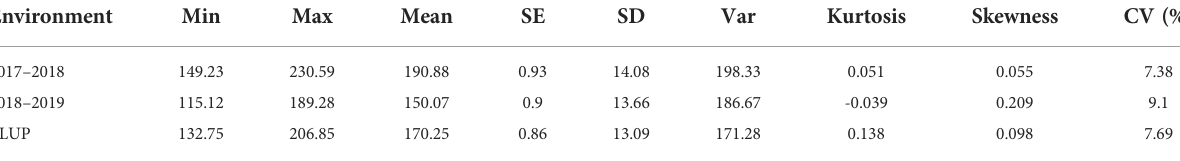
TABLE 1 Phenotypic variations of plant height in rapeseed natural population.